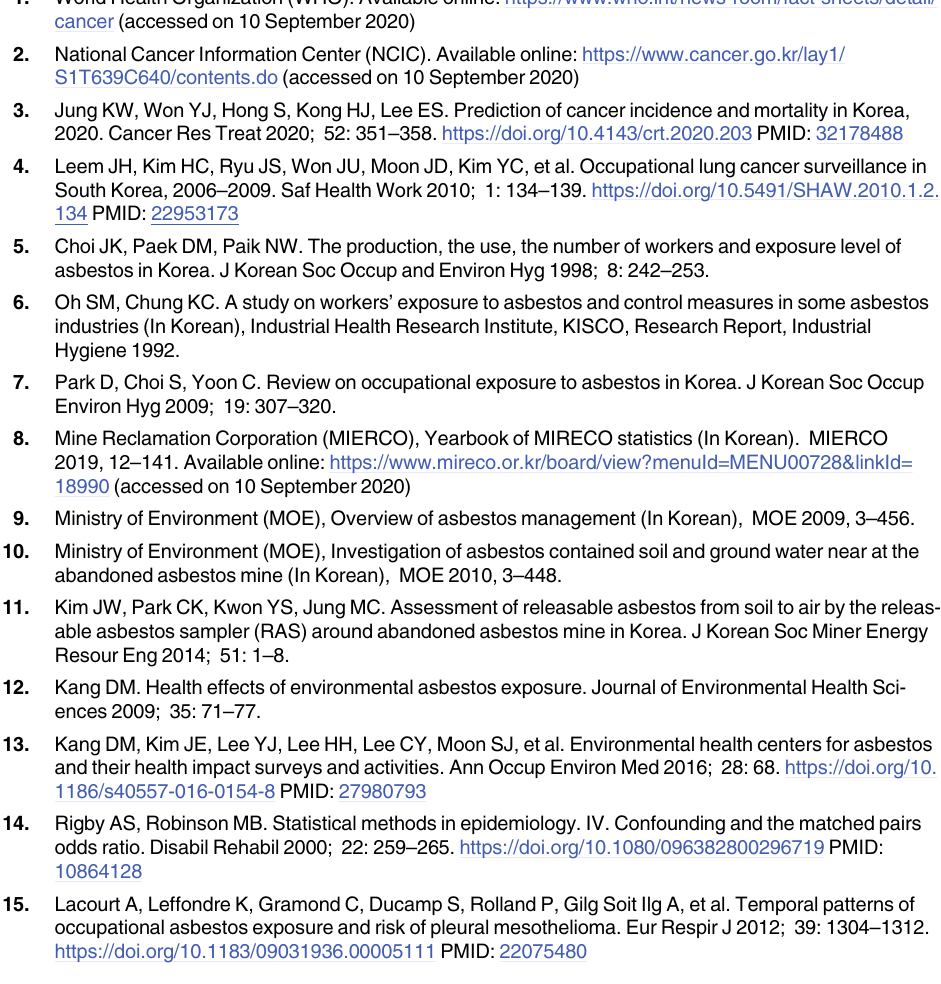
S1 Table. Questionnaire (in